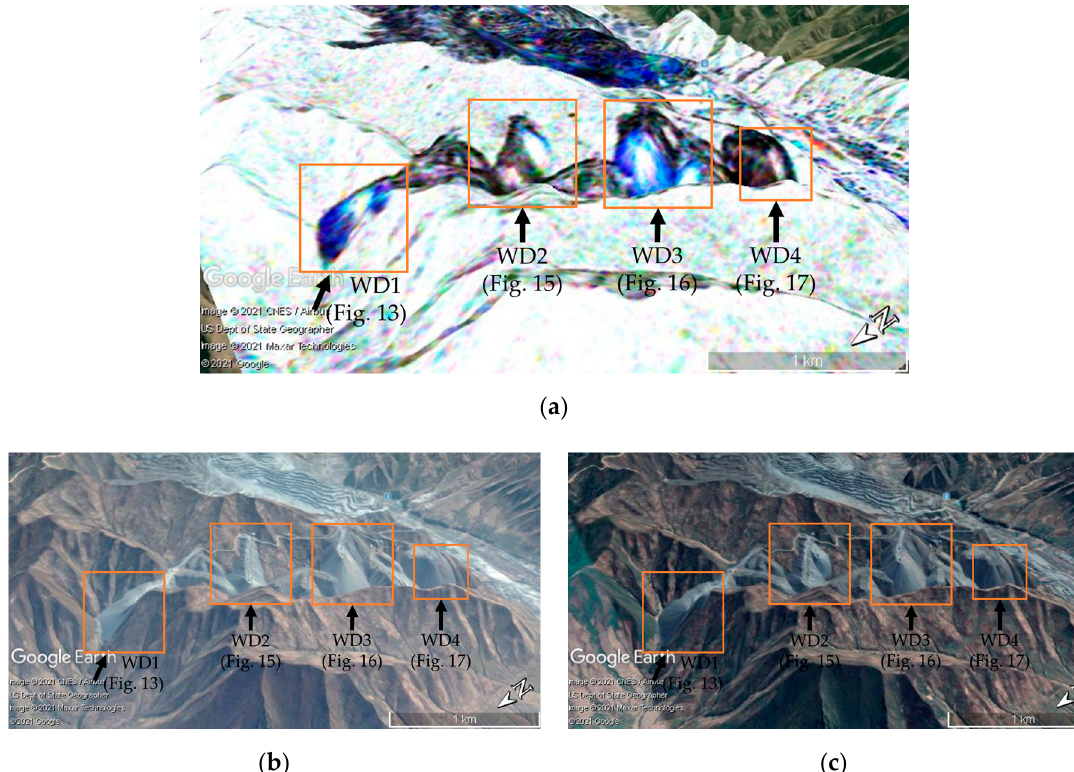
Figure 12. The west dumping area. ( a ) is the RGB composite of the annually averaged NDAI map (R: 2019, G: 2018, and B: 2017). ( b , c ) are Google Earth images taken on 7 October 2015 and 26 September 2019, respectively. Four active dumping sites named WD1, WD2, WD3, and WD4 are drawn in orange boxes, and the image viewing directions are indicated by arrows.